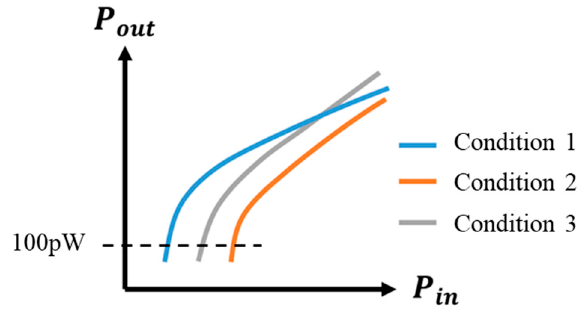
Figure 3. Determination method of the optimum parameter.